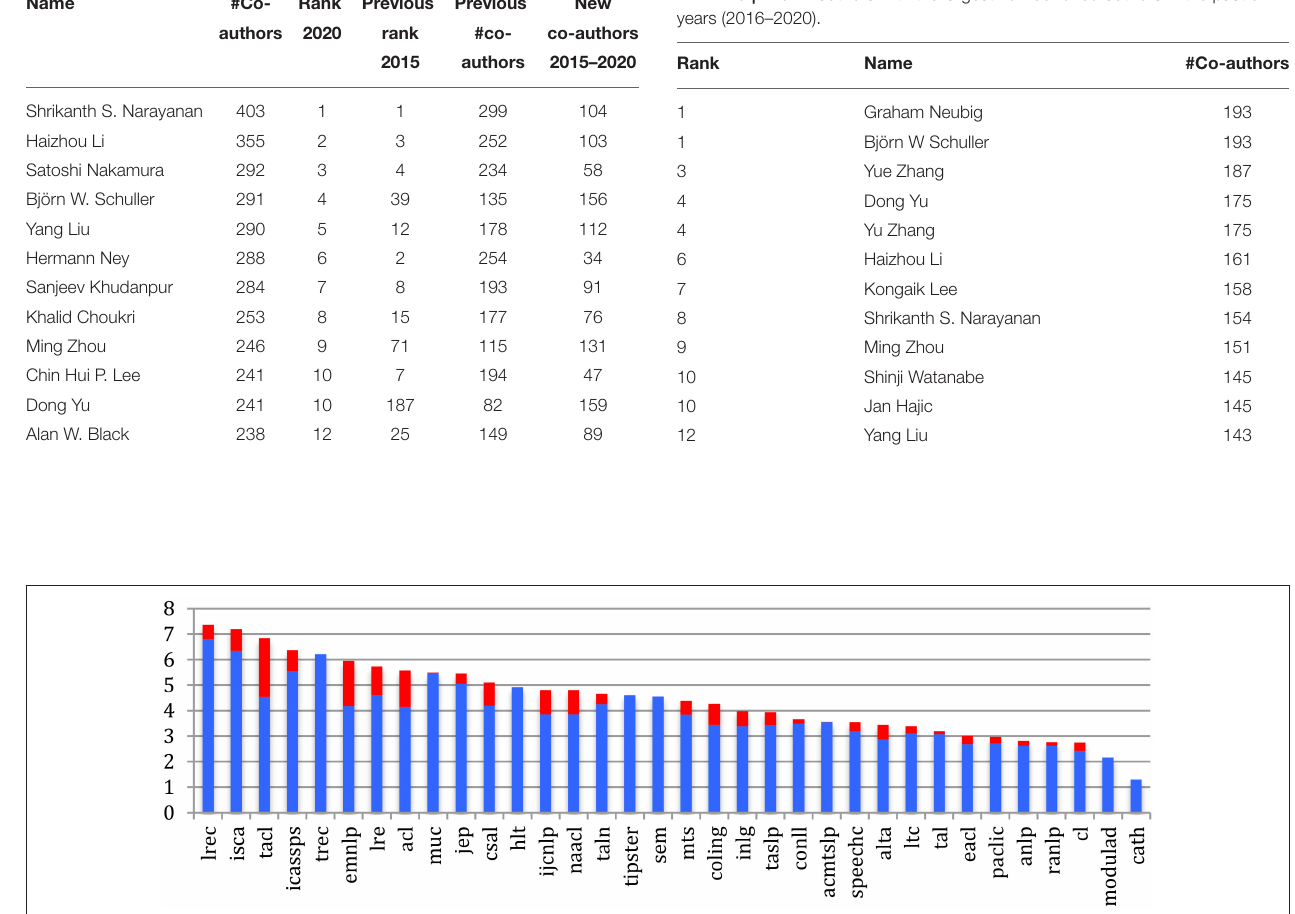
FIGURE 14 | Mean degree of the collaboration graph for the 34 sources in 2015 (blue) and 2020 (red).